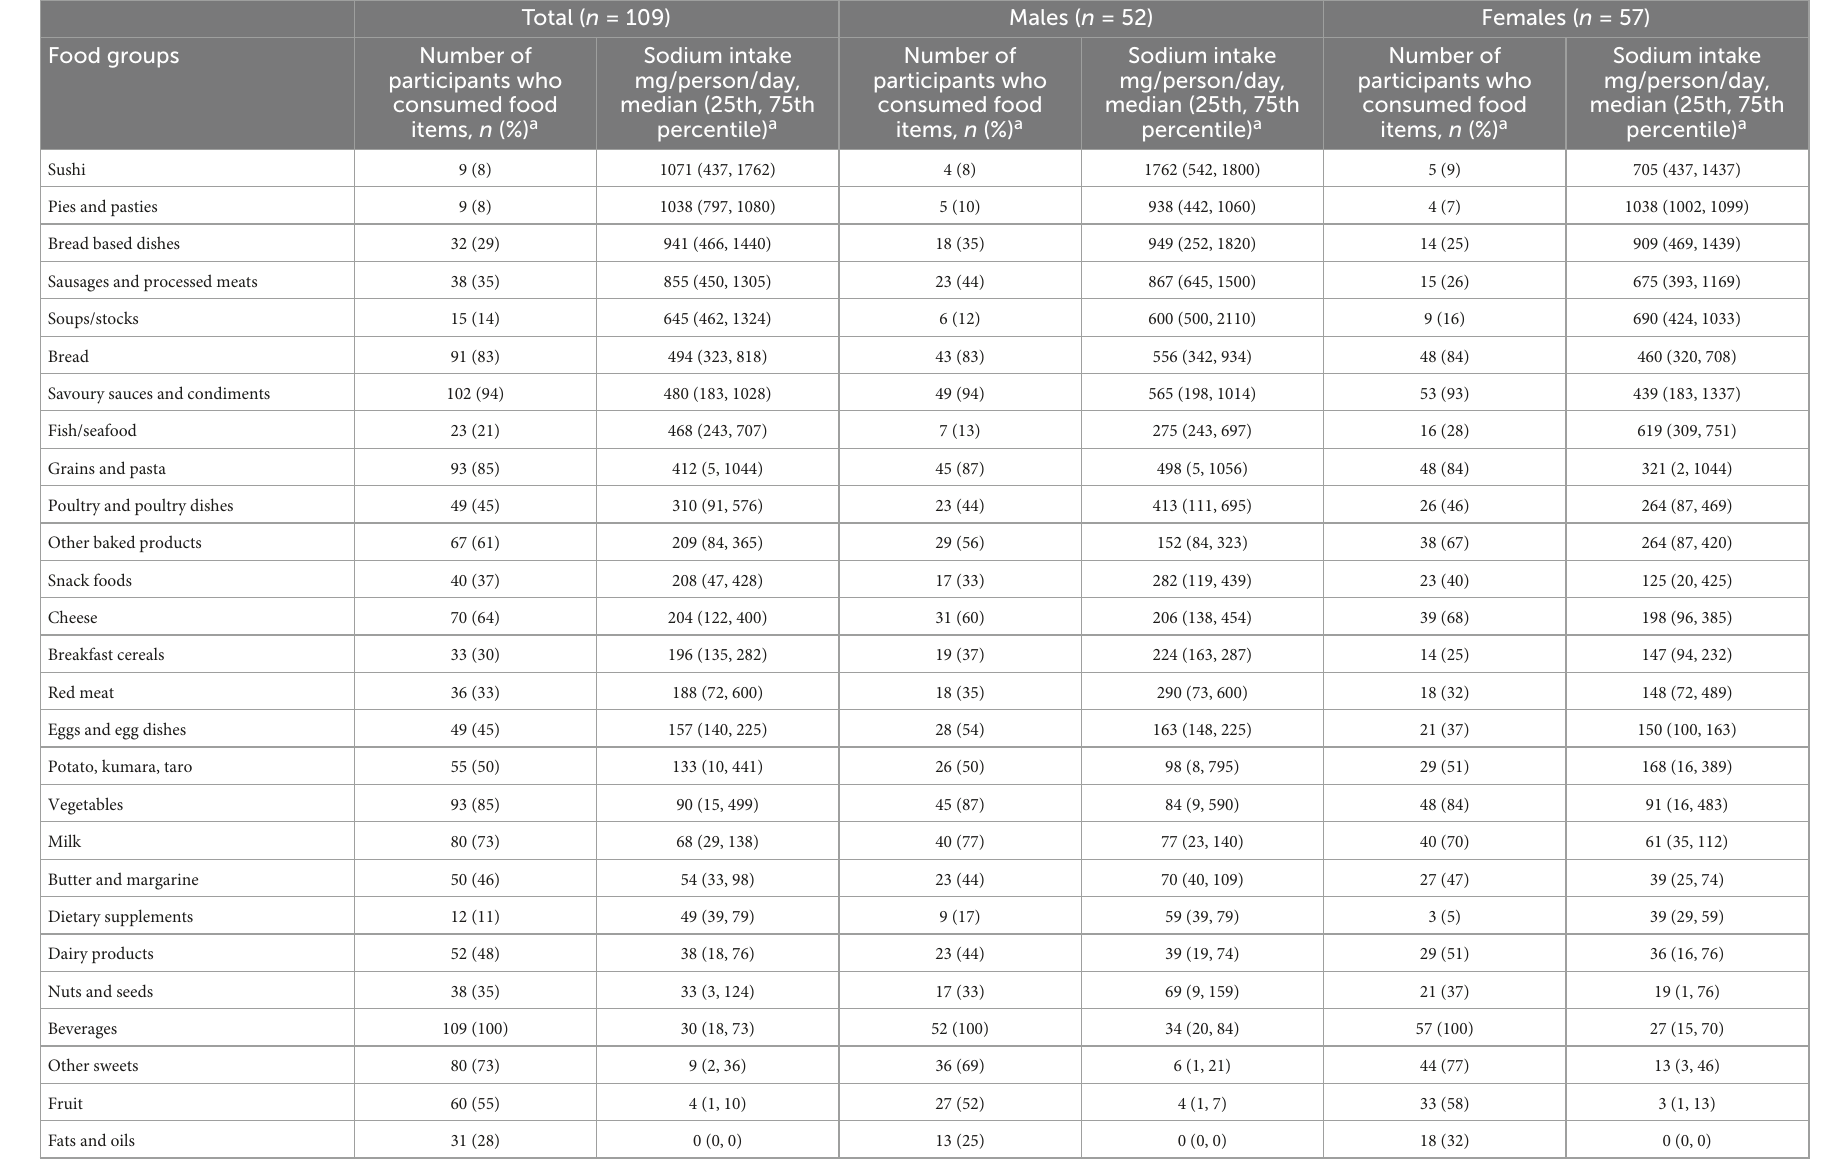
TABLE 4 Number of participants who consumed food items in each food group and median sodium intake (mg/person/day) of participants who consumed food items in each food group, in total and by